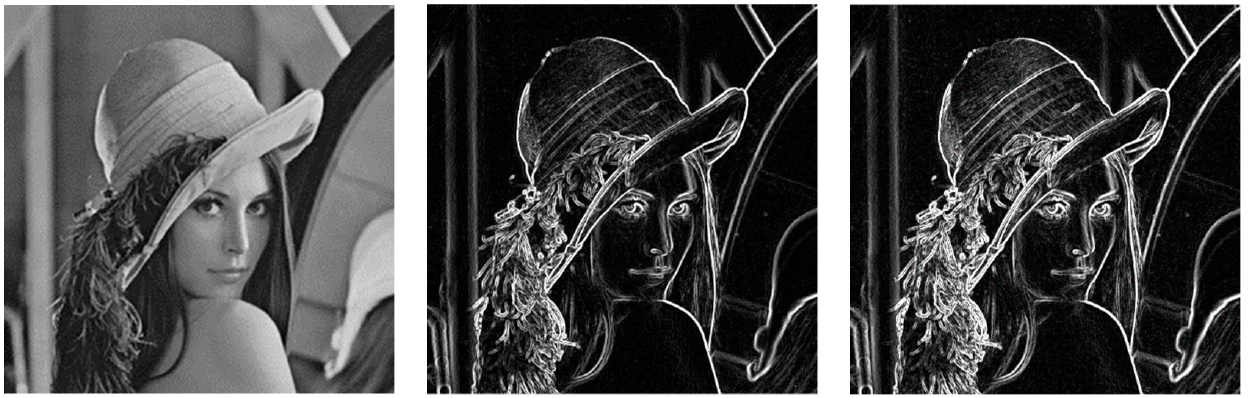
Figure 18. Sobel edge map: Left: original image; Middle: Sobel edge map using Equation (3); Right: Sobel edge map using Equation (5).